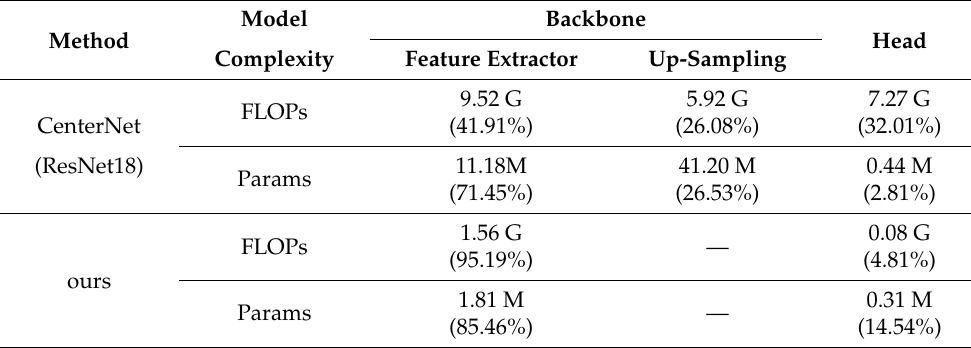
Table 2. Comparison of FLOPs and Parameters between CenterNet and our